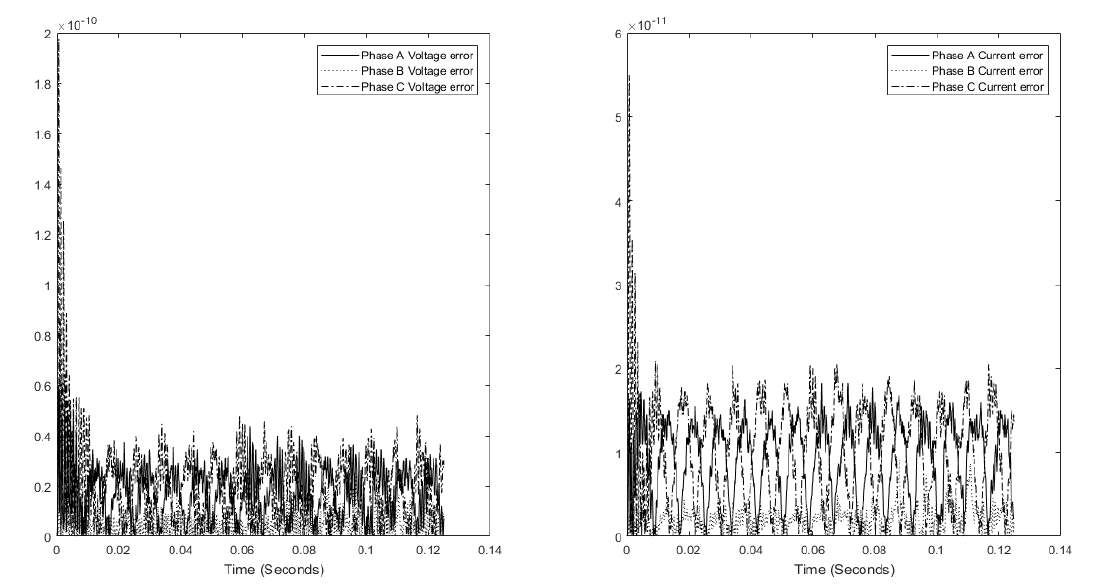
Figure 25. Simulink-NIS method error results for second test scenario.